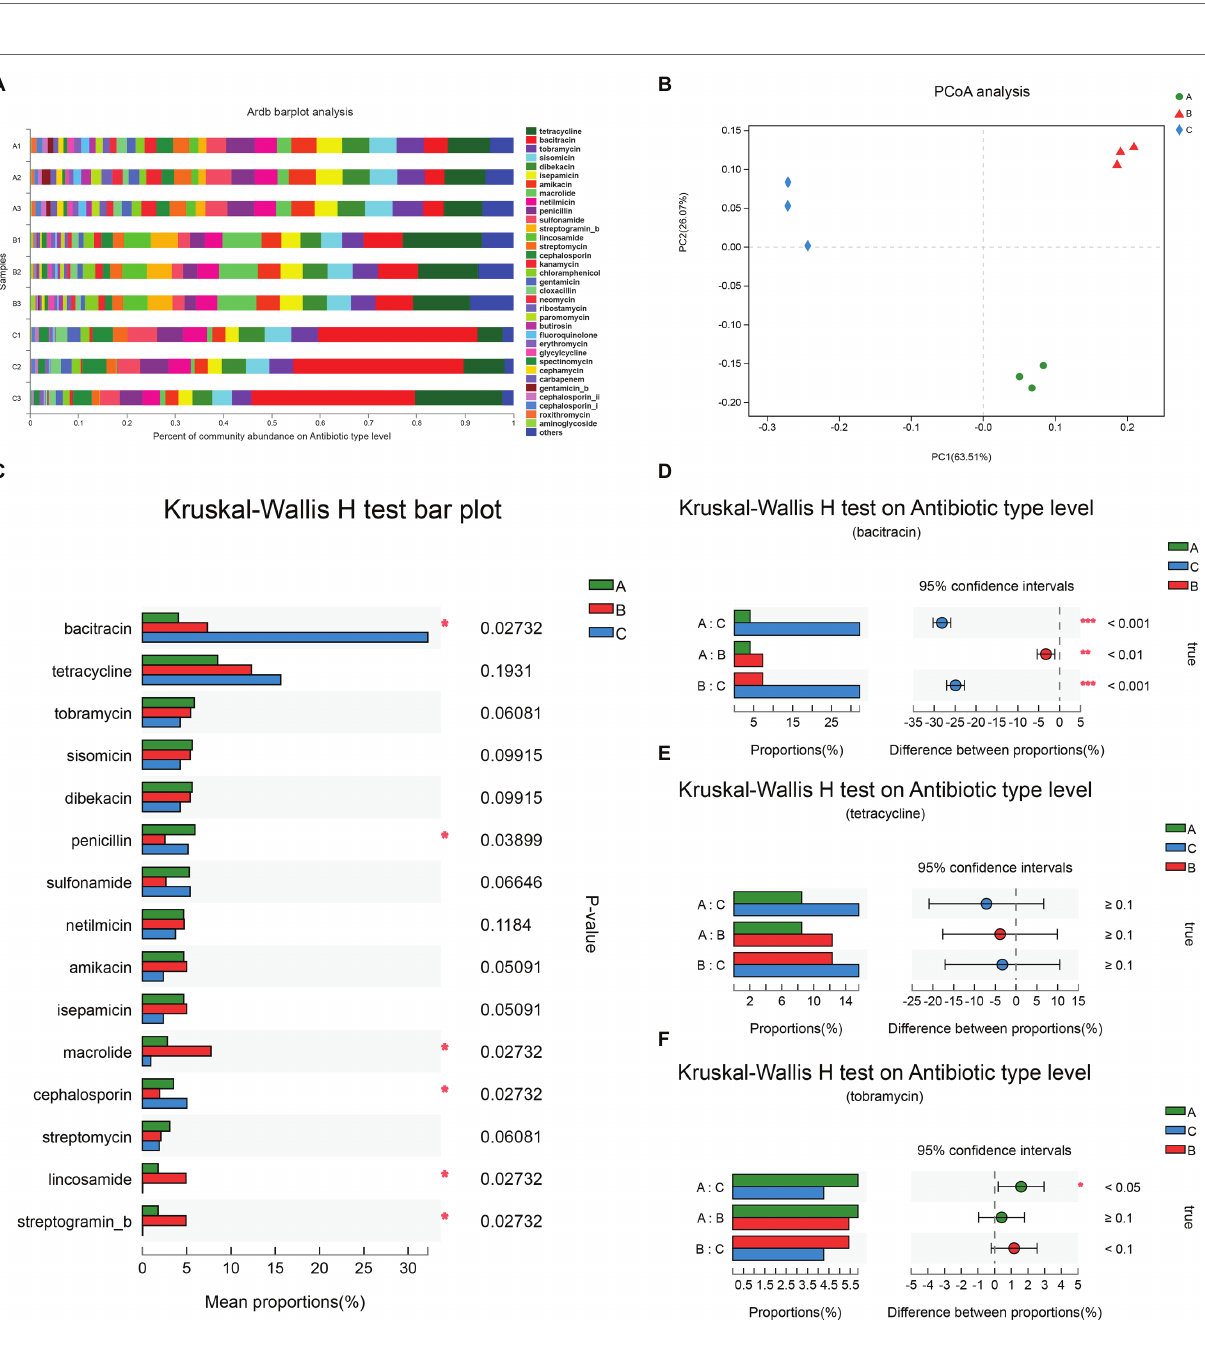
FIGURE 3 | Community abundance of antibiotic resistance genes (ARGs) and statistical comparison on antibiotic type level. (A) Percentage of community abundance on antibiotic type level; (B) PCoA analysis of community on antibiotic type level; (C) The proportions of ARGs in three groups; (D) The composition difference of anti-bacitracin genes in pairwise comparison; (E) The composition difference of anti-tetracycline genes in pairwise comparison; and (F) The composition difference of anti-tobramycin genes in pairwise comparison. Differences were considered statistically significant at * p < 0.05; ** p < 0.01; and *** p < 0.001 level. A group, samples from Affiliated Hospital of Southwest Medical University; Red triangle, B group, samples from Affiliated TCM Hospital of Southwest Medical University; Blur diamond, C group, samples from Hospital of Stomatology Southwest Medical